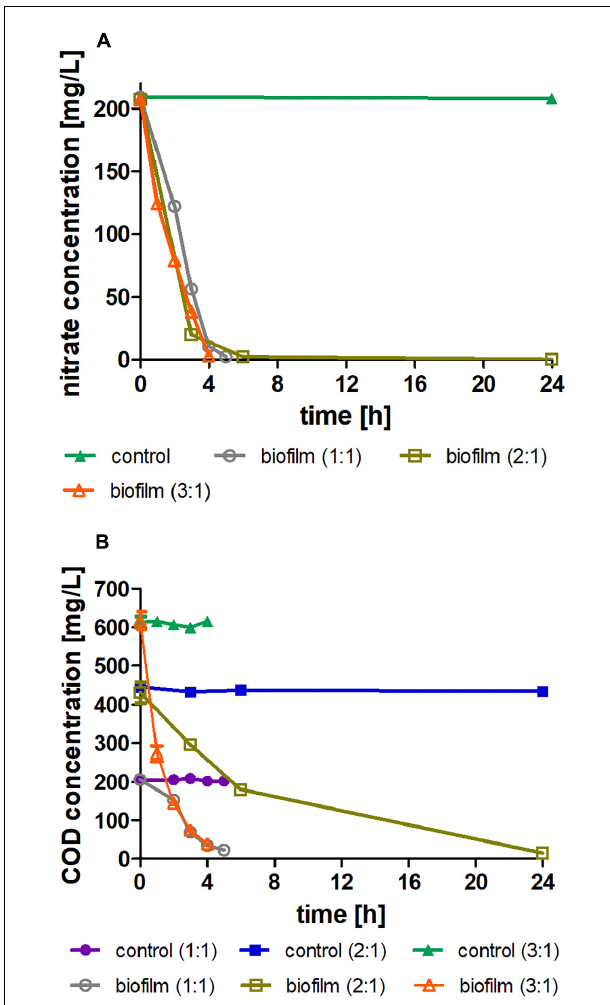
FIGURE 5 | (A) Nitrate concentration with time, where the initial concentration is 200 mg/l; treatment vs. sterile controls in biomass immobilized in aqueous solution (batch moving bed bioreactor) at three different C:N ratios (1:1, 2:1, and 3:1) and in non-immobilized biomass in suspension (flasks) at a C:N ratio of 3:1. (B) COD concentration over time, where the initial concentration varies according to the C:N ratio; treatment vs. sterile controls at three different C:N ratios (1:1, 2:1, and 3:1). The data are means of three replicates + standard deviation.